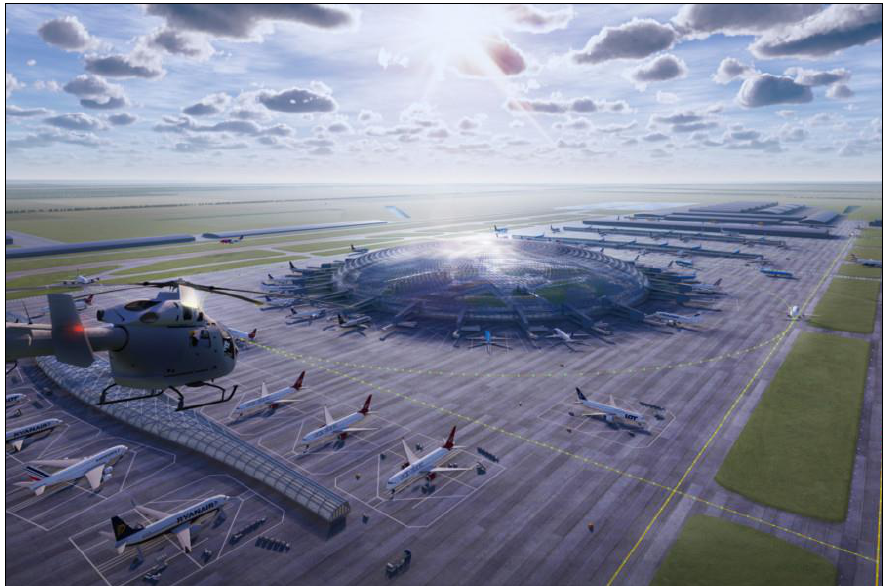
Figure 1. The Solidarity Transport Hub Poland (STH) concept by Chapman Tylor [91].